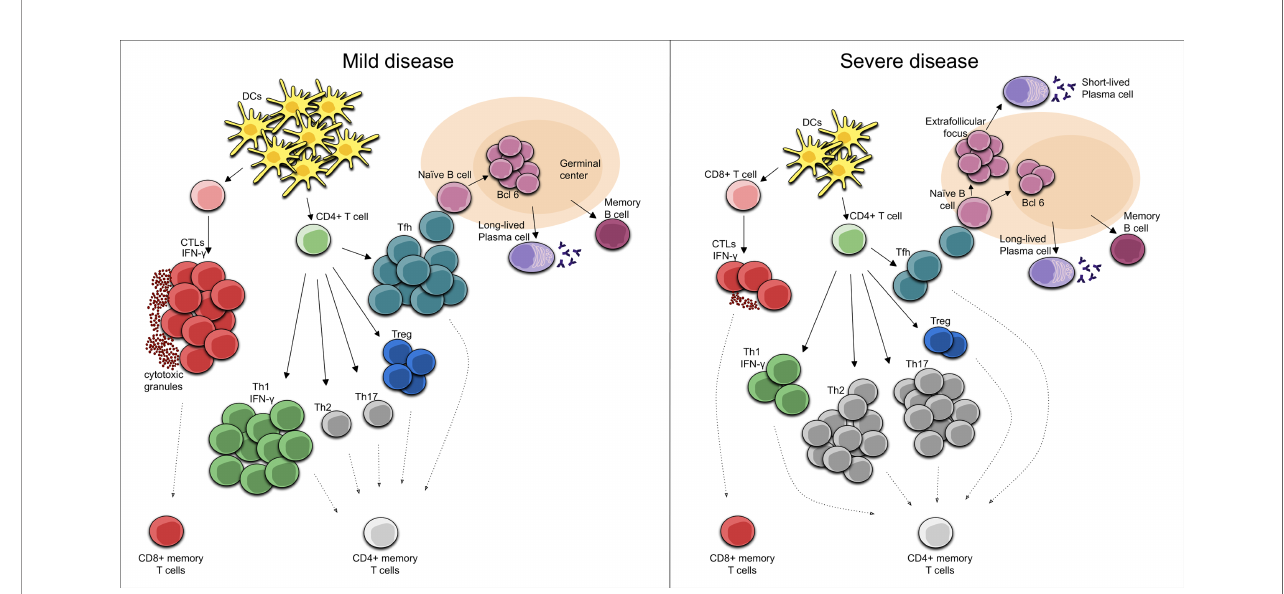
FIGURE 1 | Cellular immune response in Mild COVID-19. In mild COVID-19, there is an early induction of the Th1 cell-biased phenotype with IFN- g secreting SARS- CoV-2-speci fi c T cells. In turn, SARS-CoV-2-speci fi c CD8+ T cells perform rapid responses, acting as CTLs, secreting cytotoxic granules and high levels of IFN- g . Moreover, activated Tfh cells in the draining lymph nodes activate the naïve B cells that are necessary for the development of long-lived plasma cells and memory B cells. Cellular immune response in Severe COVID-19. During a severe course of COVID-19, there are reduced numbers and functions of DCs, leading to decreased numbers of CD4+ T cells. In this case, an elevation of Th2 phenotype and/or a dysregulation of the Treg/Th17 cell ratio toward the Th17 phenotype can be seen. Furthermore, decreased numbers of CD8+ T cells with an exhausted phenotype results in reduced CTL functionality while the T cell-mediated activation of B cells in extrafollicular focus induces their differentiation into short-lived plasma